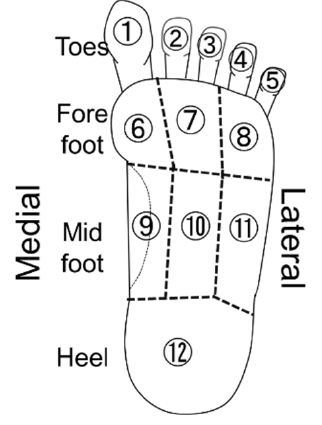
Figure 1. Plantar segments.